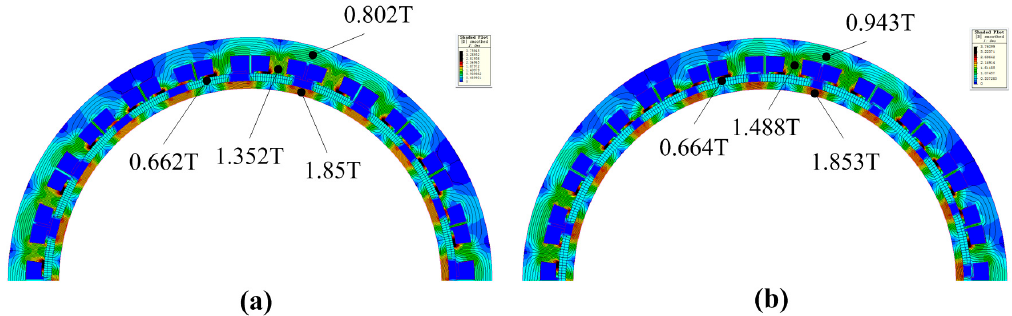
Figure 21. Magnetic field distribution ( a ) Initial design model ( b ) Optimized model.